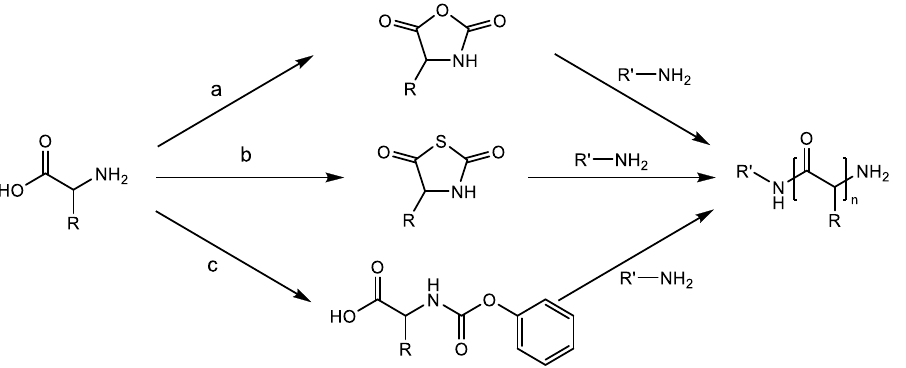
Figure 1. Polymerization of three kinds of activated monomers. (a) Phosgene or its derivatives; (b) Ethyl alkoxydithioformate and PCl 3 ; (c) Phenyl chloroformate or dibenzyl carbonate.